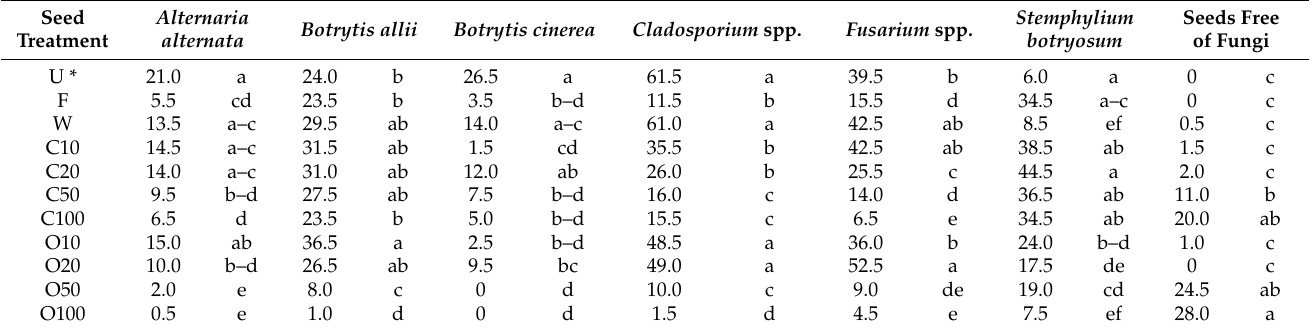
Table 5. Effects coconut and oregano hydrolates treatment on the incidence of fungi on onion seeds of sample I and seeds free of fungi